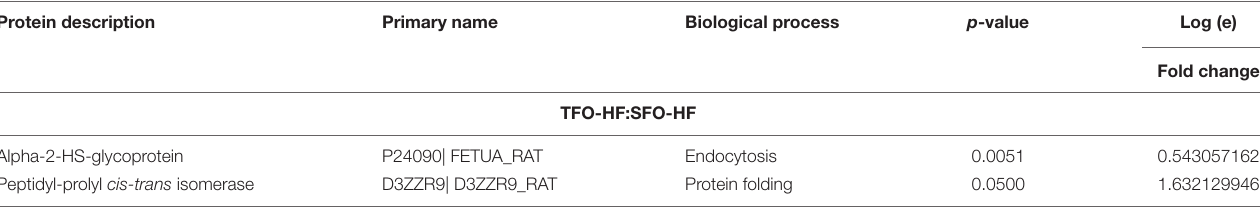
TABLE 3 | Protein abundance levels related to miscellaneous functions from TFO-HF: SFO-HF analysis considering only proteins with up-regulation and down-regulation ( p ≤ 0.05) with a delta ( (cid:49) ) of at least ( ≥ ) 0.5-fold change. Protein